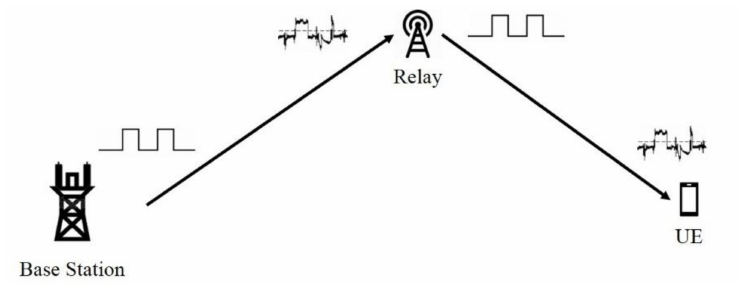
Figure 2. The system model of the DF relaying scheme.